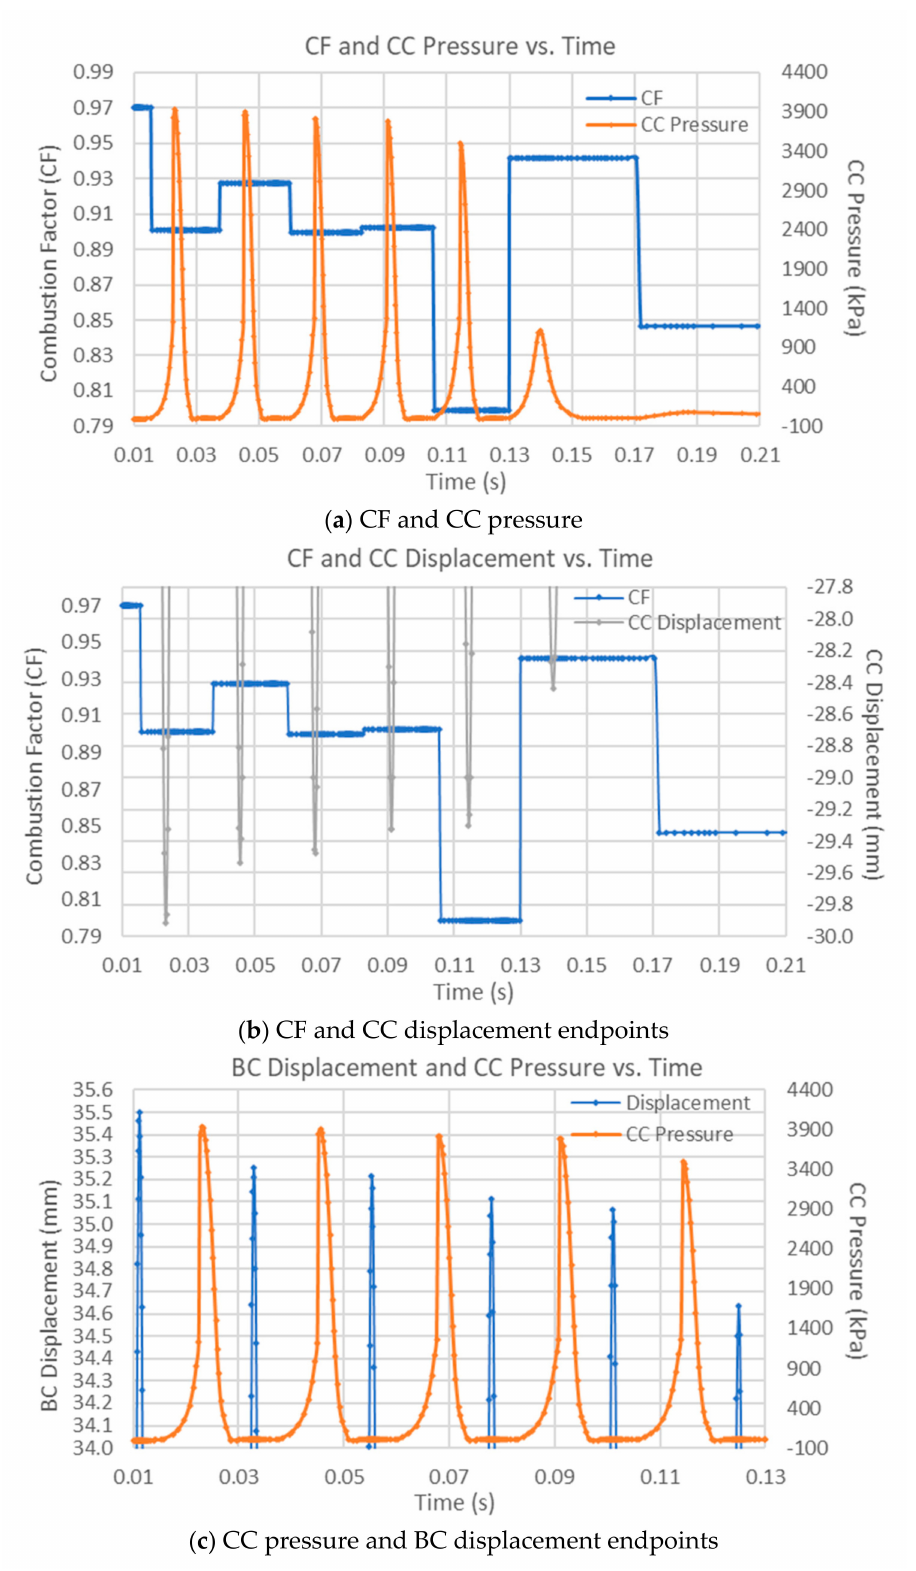
Figure 18. ( a ) CF and CC pressure vs. time, ( b ) CF and CC displacement endpoints vs. time, ( c ) CC pressure and BC displacement endpoints vs. time at 0.87 ±